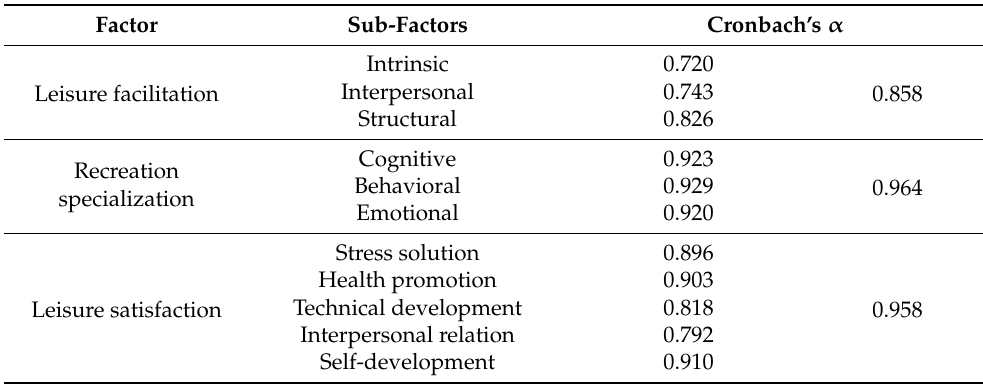
Table 3. Results of the Reliability Analysis.